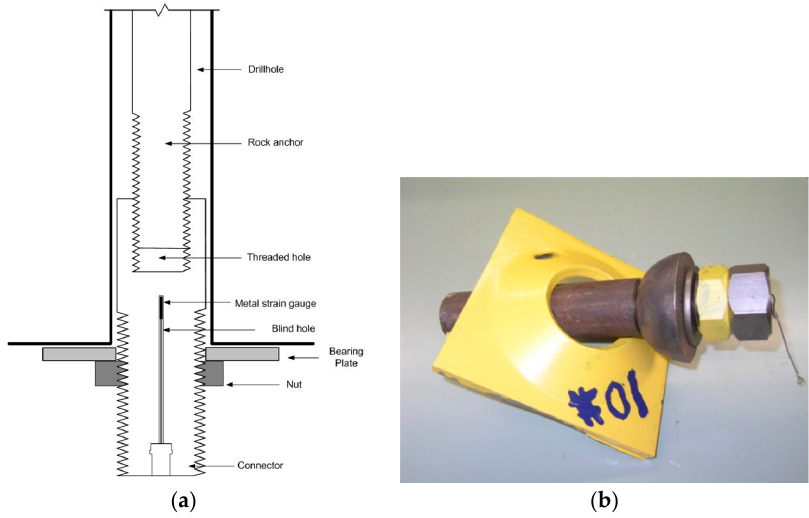
Figure 8. ( a ) The coupler load cell design concept; ( b ) photo of the coupler load cell [38].